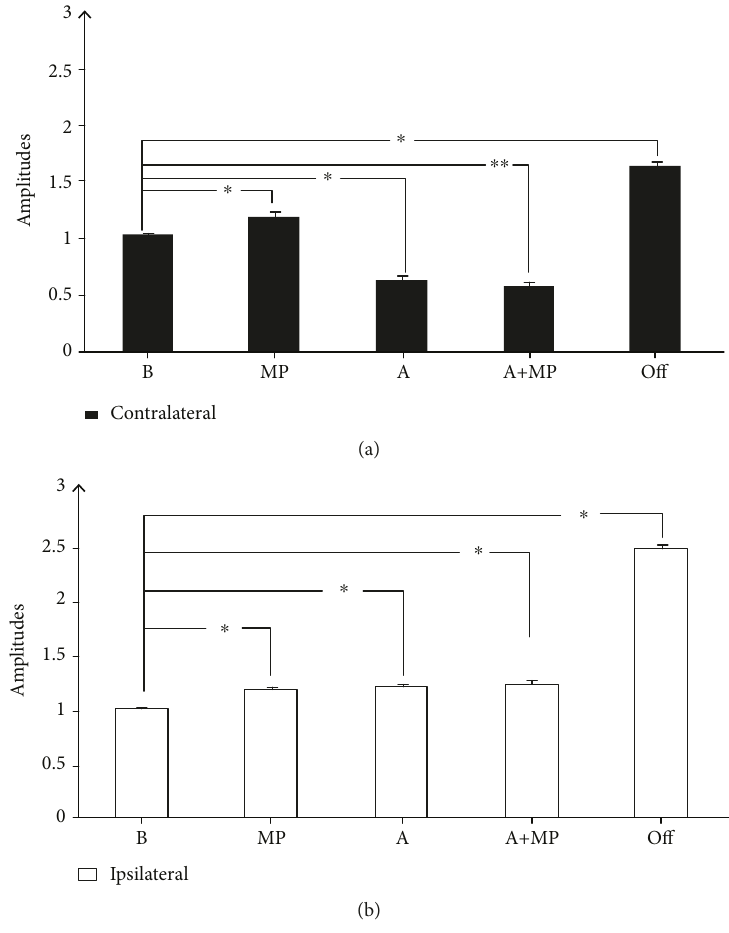
Figure 5: Results of the behavioral test. In B (before), MP (motor practice), A (in-situ acupuncture), A+MP (acupuncture+motor practice), and O ff were assessed by the average of MEP amplitudes (a) contralateral and (b) ipsilateral at time points B, MP, A, A+MP, and O ff normalized to the baseline. All data are mean ± SD of nine participants. The asterisks indicate statistical signi fi cance (one-way repeated measure